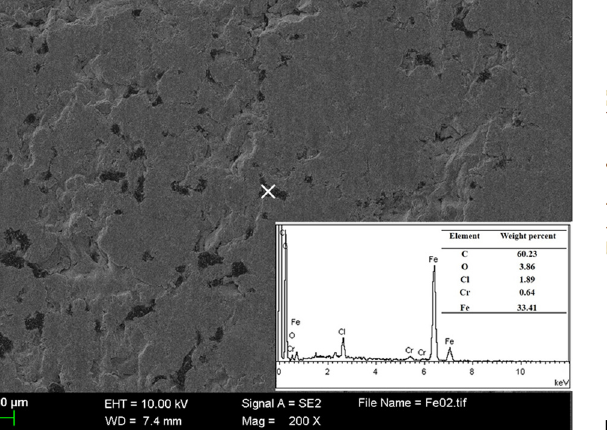
Figure 11: SEM micrographs and EDX spectra of cylinder liner specimens after test.